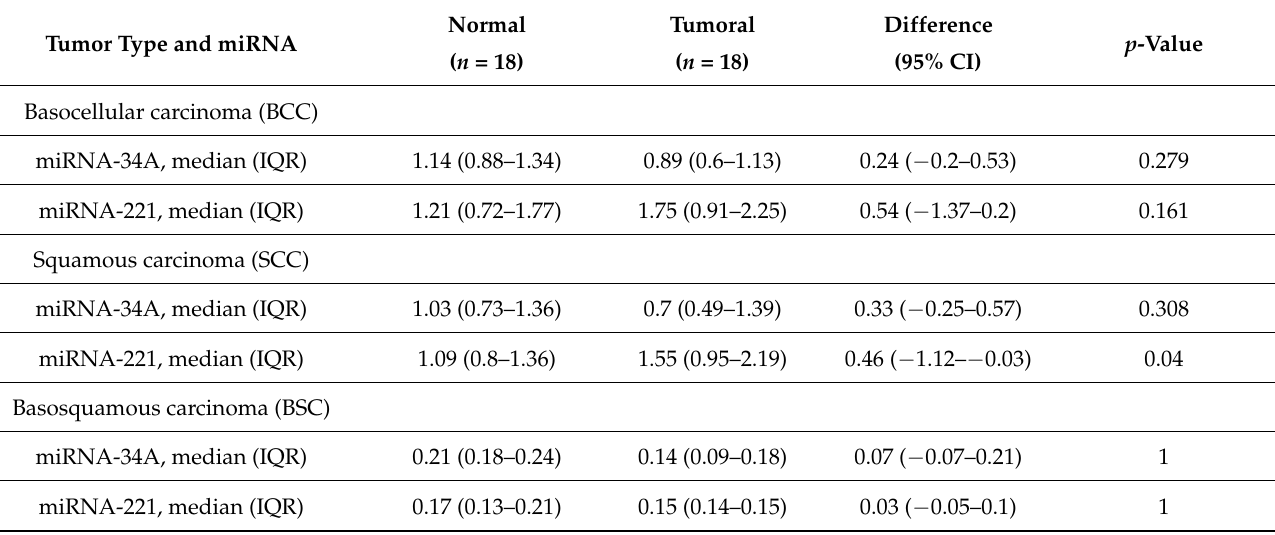
Table 3. Comparison between tumoral and adjacent tissue regarding miRNA-34a and miRNA-221